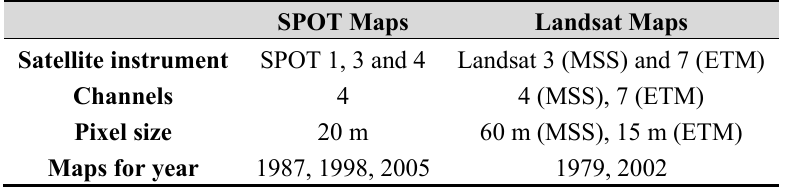
Table 5. Summary of the land-use maps derived from SPOT and Landsat optical